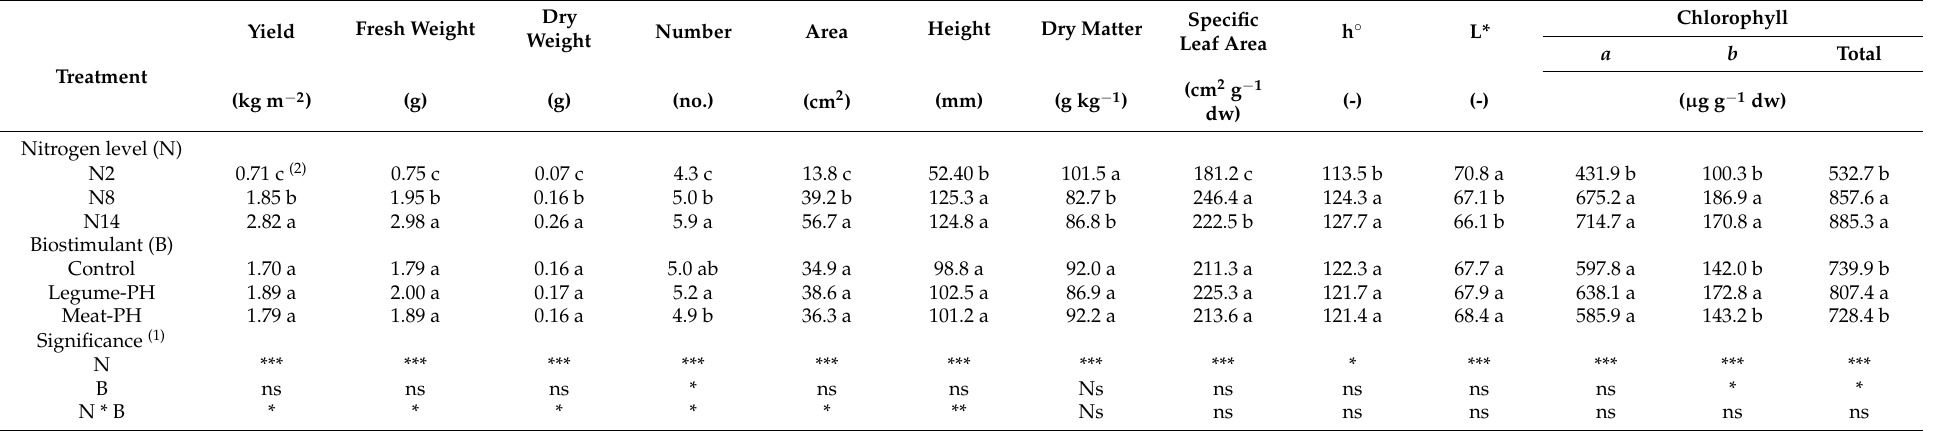
Table 1. Yield, growth, and bio-morphological features of spinach leaves as affected by nitrogen nutrition and the foliar application of biostimulants.